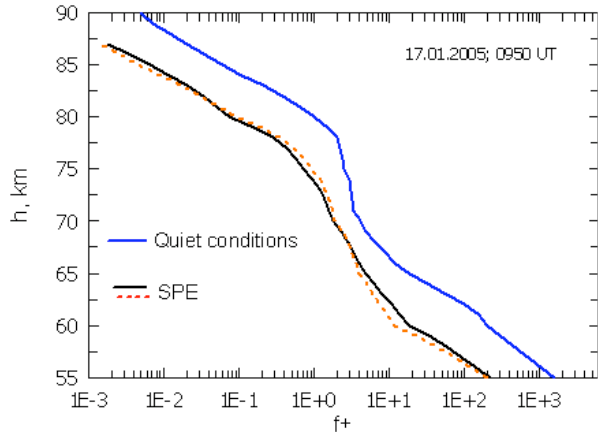
Fig. 7c. α eff profiles calculated for quiet conditions (blue curve) using the O, O 3 and NO profiles 1–3 in Fig. 1 and for the SPE on 17 January 2005 at 09:50UT using profiles 4–6 in Fig. 1 (black curve) and 1–3 in Fig. 1 (red dashed